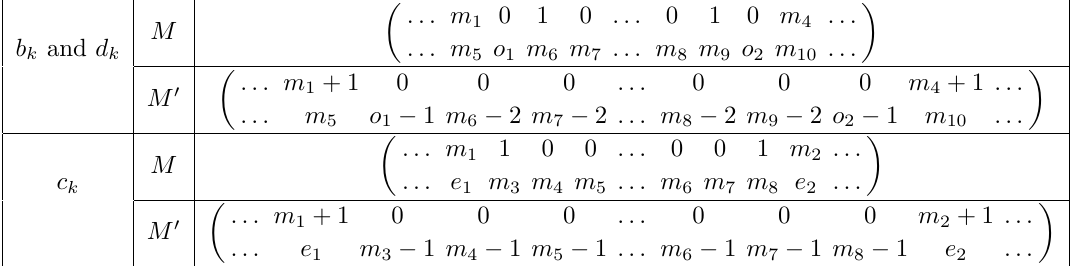
Table 9. Classi(cid:12)cation of minimal singularity type Kraft-Procesi transitions for orthosymplectic brane con(cid:12)gurations in the matrix formalism . Labels e i denote numbers that are even while o i denotes odd numbers. m i denote any integer number. In all the initial matrices M , let M 1 j and M be the elements with value 1. In the (cid:12)rst two rows if l is odd the singularity is b , if 1( j + l ) ( l +3) = 2 l is even the singularity is d . In the last two rows the singularity is c . M is a matrix ( l +4) = 2 ( l +2) = 2 before the KP transition is performed. M 0 depicts the matrix after the KP transition is performed.